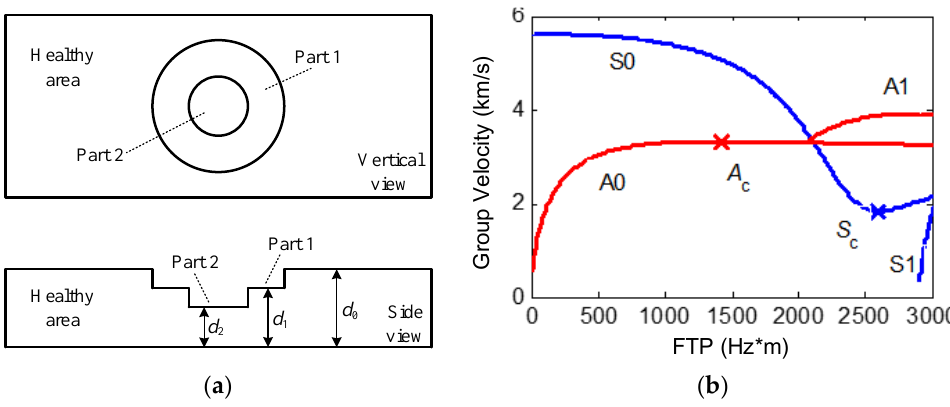
Figure 1. Research object in an aluminium plate. ( a ) A typical circular defect with variable depth and ( b ) the dispersion curves of a Lamb wave (LW)’s group velocity in the aluminium plate.